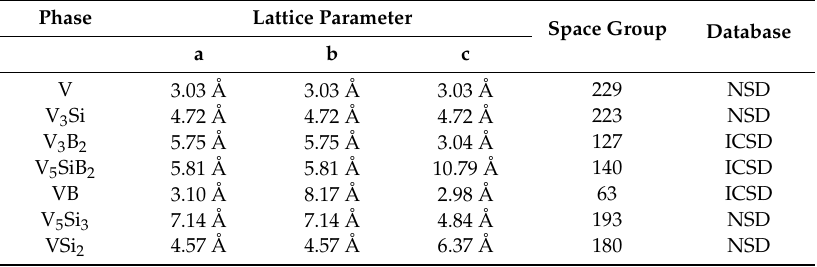
Table 1. Crystallographic data used for EBSD phase